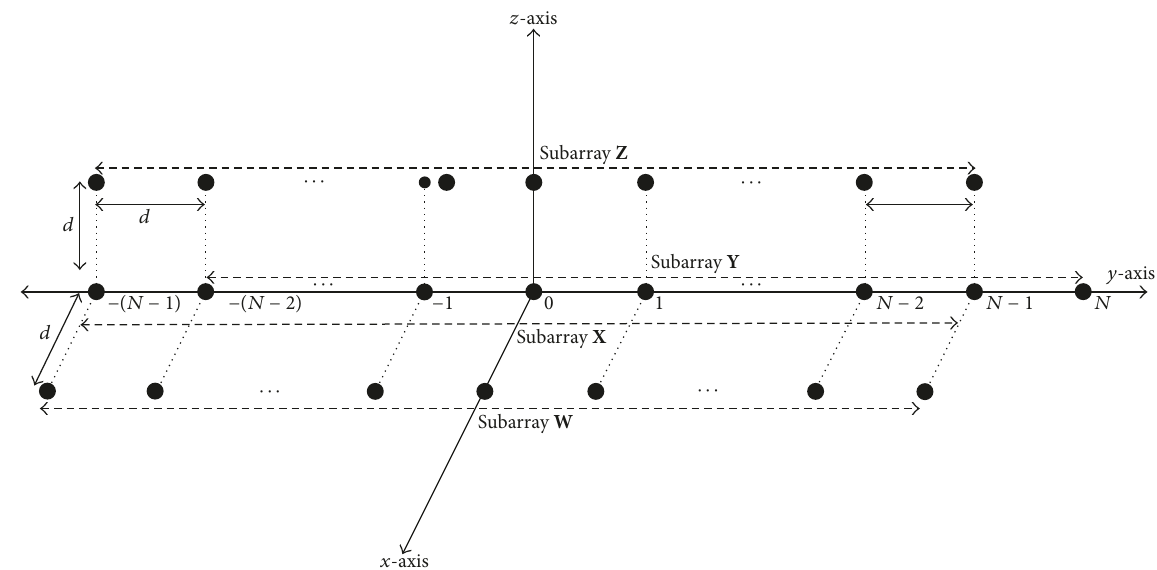
Figure 1: Geometry of the proposed extended parallel-shaped